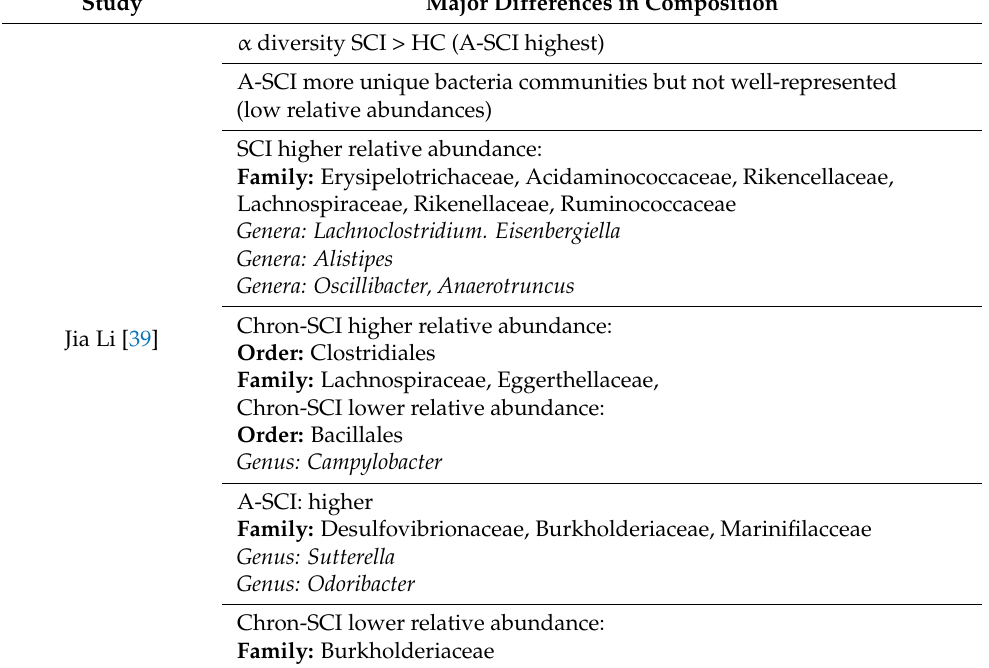
Table A3. Diversity and Taxonomic outcomes per